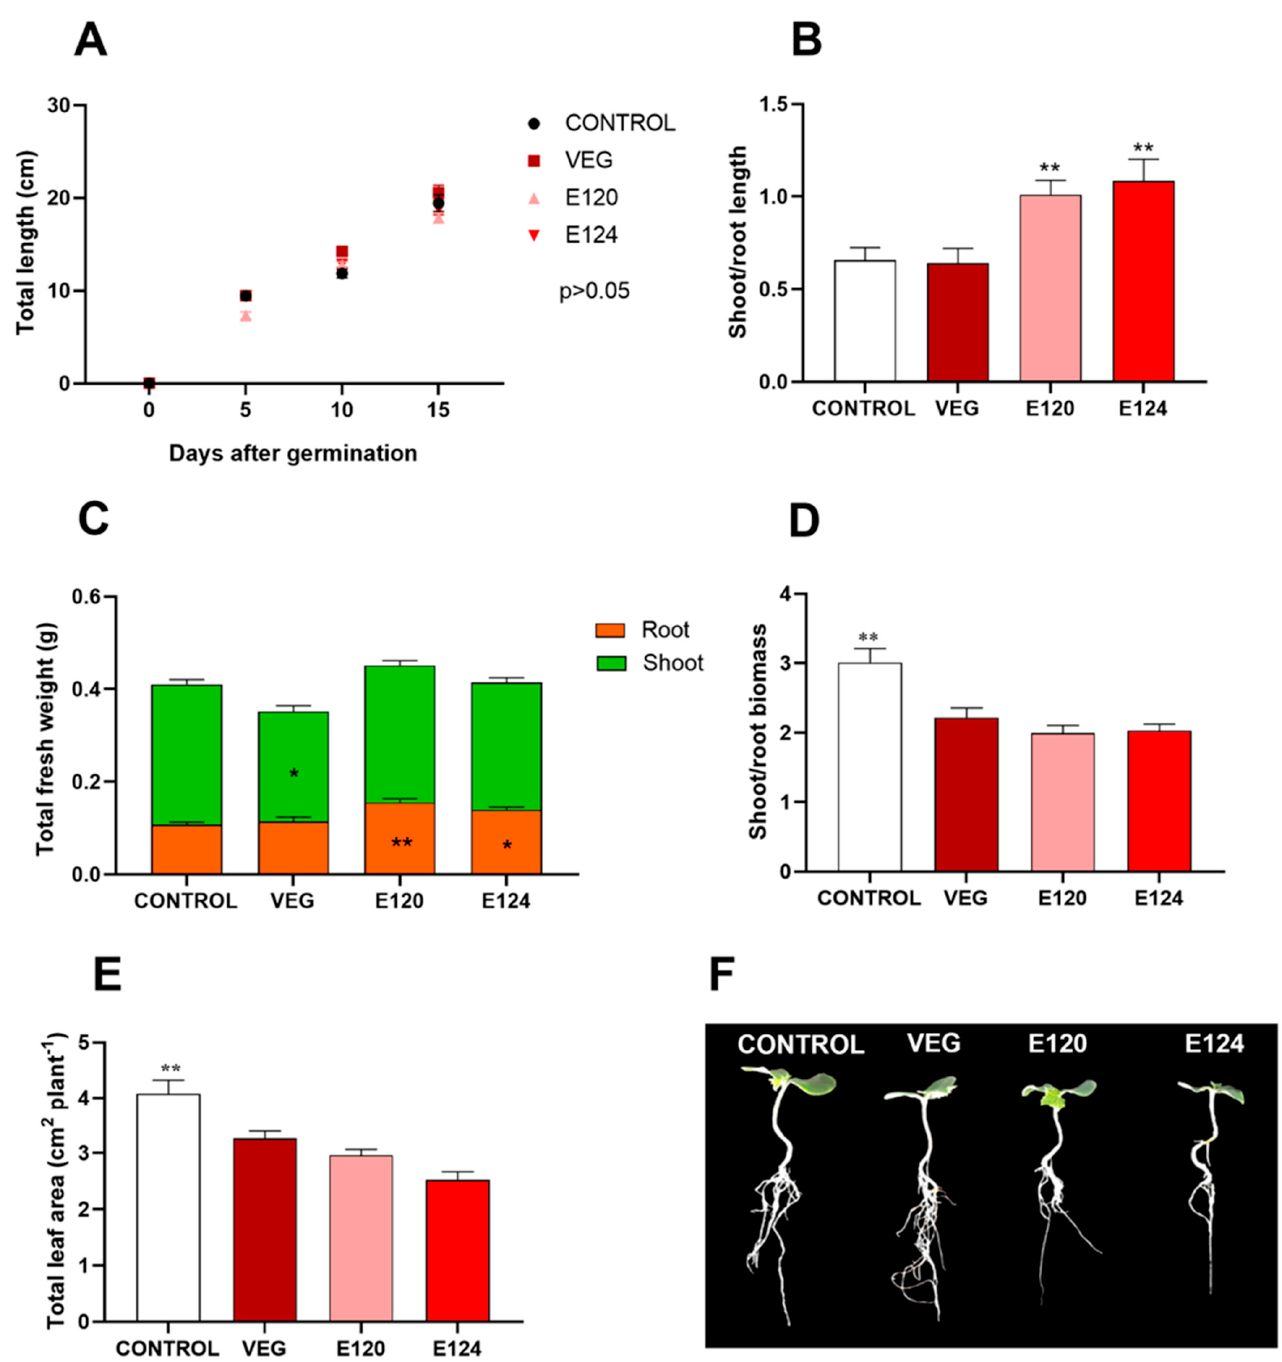
Figure 6. Effect of vegan red VEG, E120 or E124 on Cucumis sativus seedlings elongation (up to 15 days) ( A ), and on shoot/root ratio in terms of length ( B ), total fresh biomass and distribution between shoot and root ( C ), shoot/root ratio in terms of fresh biomass ( D ), total leaf area ( E ) of Cucumis sativus seedlings at 15 days after germination. Individual seedlings at 15 days are compared in ( F ). (Data are mean ± SE; n = 20; * p < 0.05; ** p <